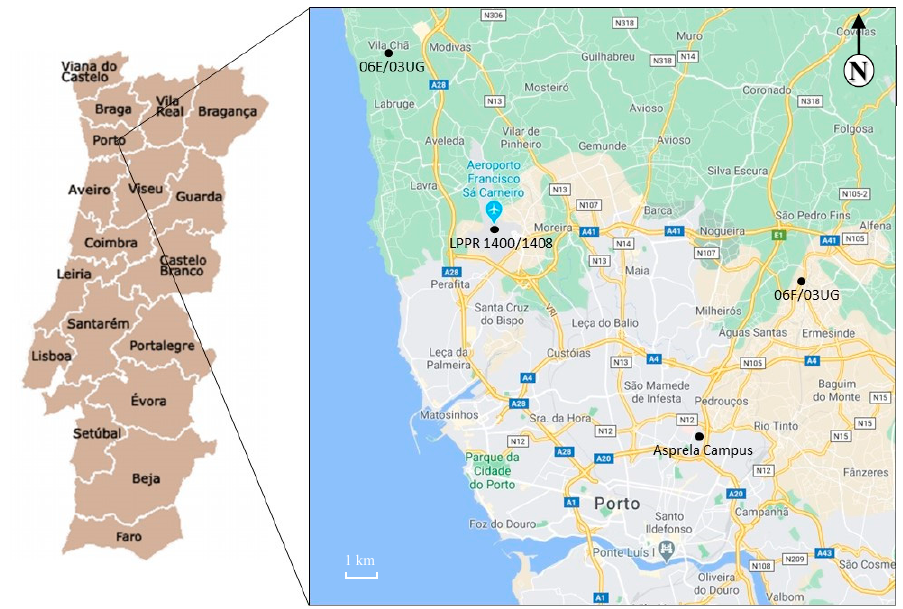
Figure 1. Location of the university campus of Asprela, Porto, Portugal (Google Maps, 2020).